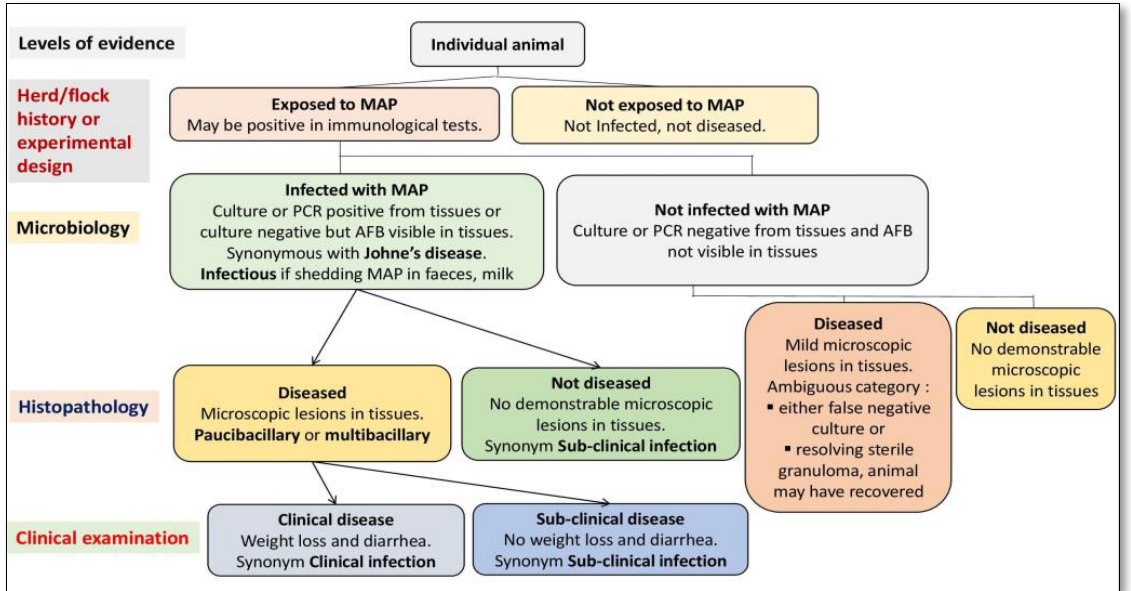
Figure 2. Primary classification of animals exposed to Mycobacterium avium subspecies paratuberculosis (MAP) using a systematic diagnostic approach.